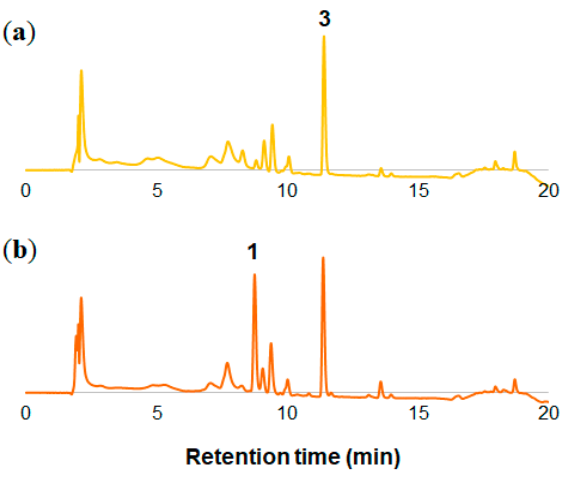
Figure 5. HPLC chromatograms of the extracts of the petals of O. laciniata . ( a ) Yellow petals at 0 h. ( b ) Orange petals at 12 h.